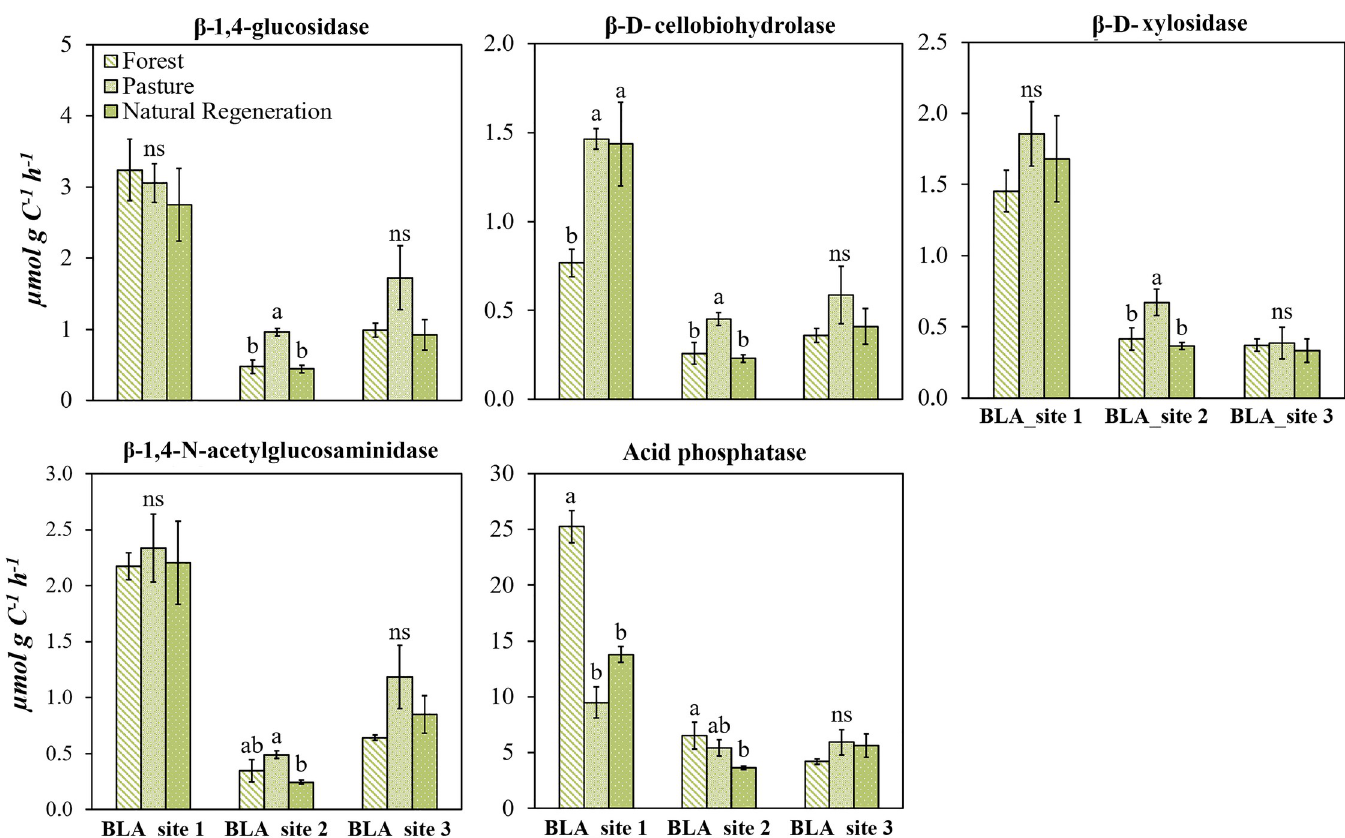
Fig 7. Specific activity per unit of SOC of soil enzymes β -Glucosidase, β -Celobiosidase, β -Xylosidase, N-acetyl- β -Glucosaminidase, and acid phosphatase in the soil of the forest, pasture, and natural regeneration in mountain landscape sites over an Andes-Amazon transition in Colombian Amazon region. Error bars denote error deviation. Means followed by the same lowercase letter in each study site did not differ among themselves according to Tukey’s HSD test (p < 0.05).